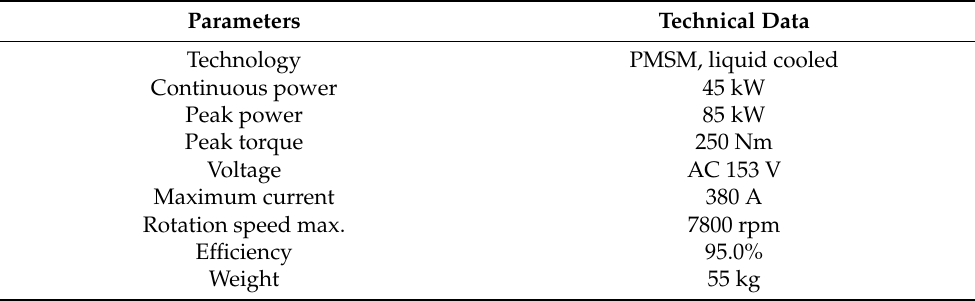
Table 2. Electric motor